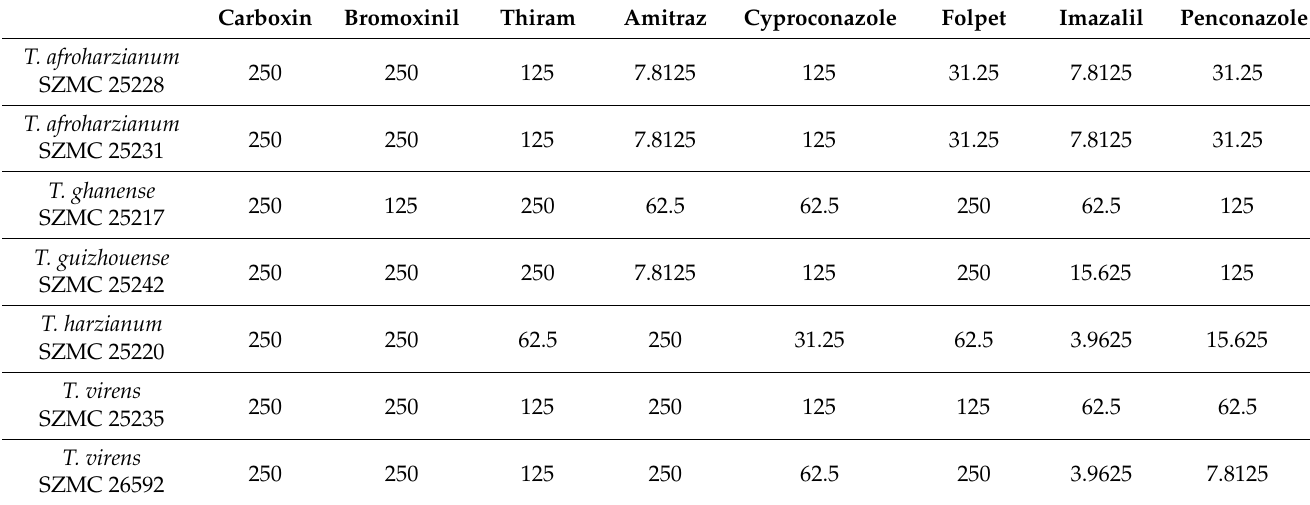
Table 2. Minimum inhibitory concentration (MIC) values ( µ g mL − 1 ) of the tested fungicides towards Trichoderma